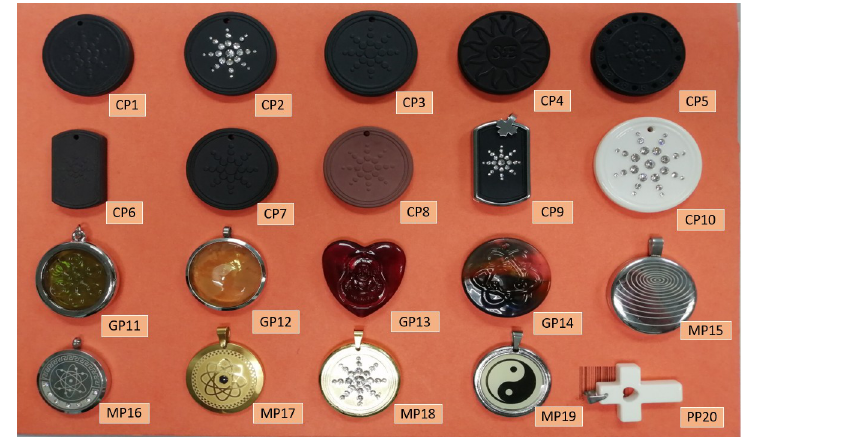
Fig 1. Scalar energy pendant samples.